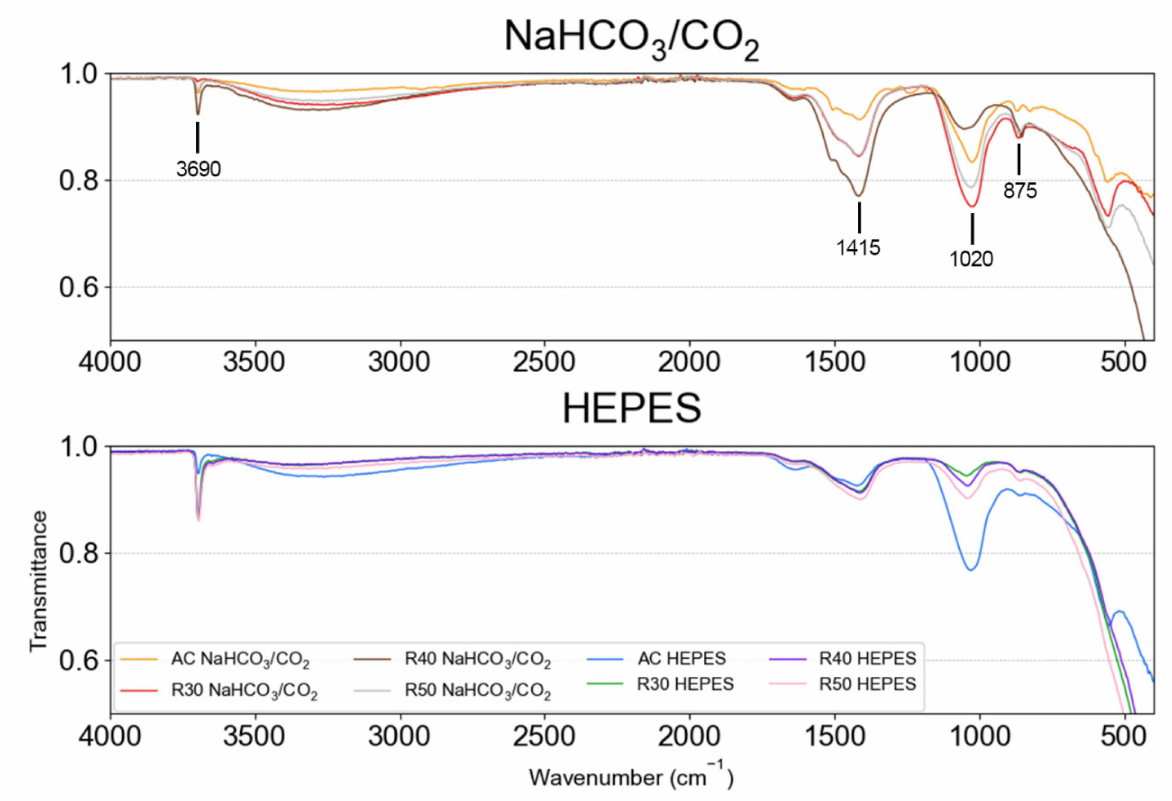
Figure 7. FTIR spectra of corrosion products collected from the surface of specimens immersed in EBSS for 15